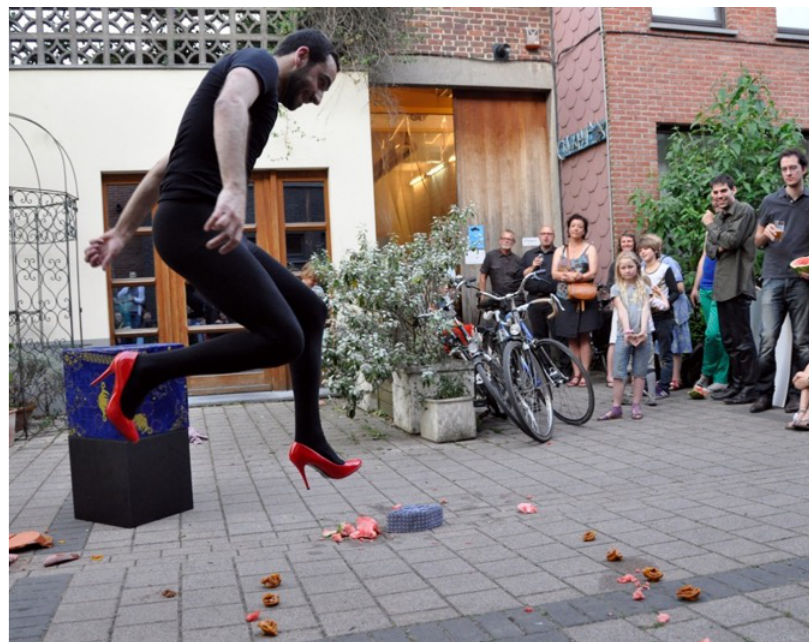
Mehdi-Georges Lahlou, Stupidité contrôlée, ou autoportrait en équilibre à la tajine (detail), 2011. Performance. Croxhapox, Gent, Belgium. Image courtesy of the artist, Galerie Transit, Mechelen, Belgium, and Galerie Rabouan Moussion, Paris, France. (photo: Bert de